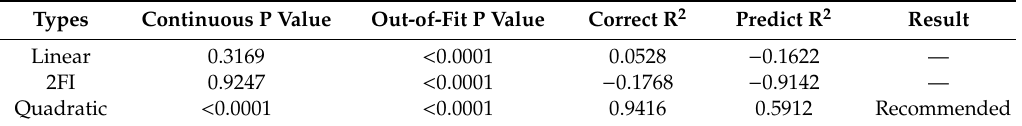
Table 10. Comprehensive analysis of fitting degree. 2FI, two-factor